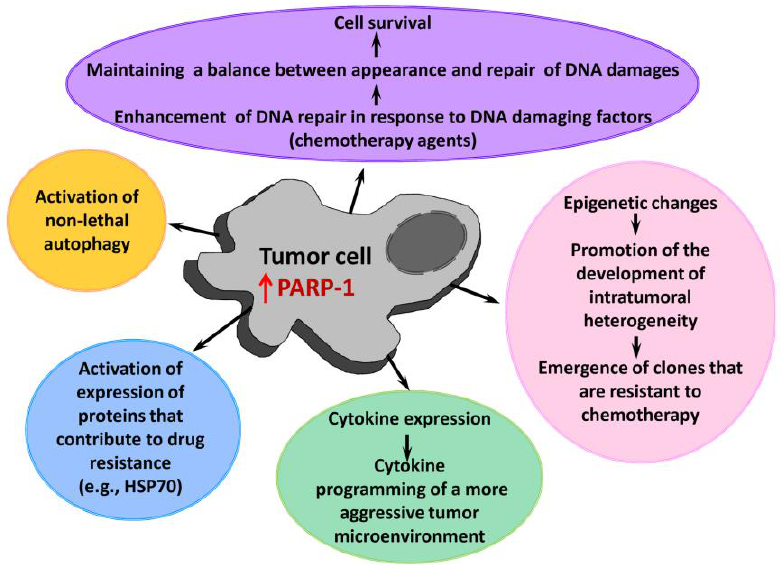
Figure 4. A role of PARP-1 in the tumor progression and development of its drug resistance. HSP70— heat shock protein 70.